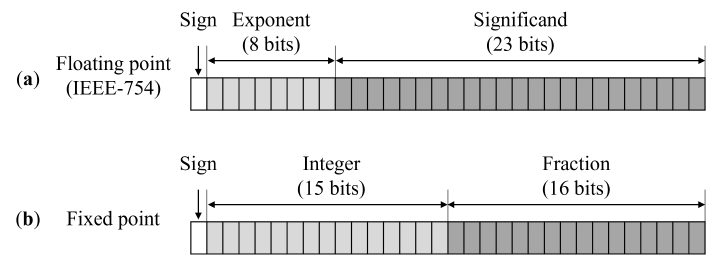
Figure 11. The 32 bit ( a ) floating-point format and ( b ) fixed-point